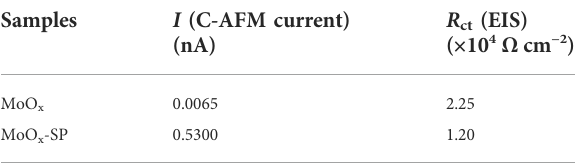
TABLE 1 Average current and R ct of the MoO x and MoO x -SP thin fi lm from C-AFM and EIS results.